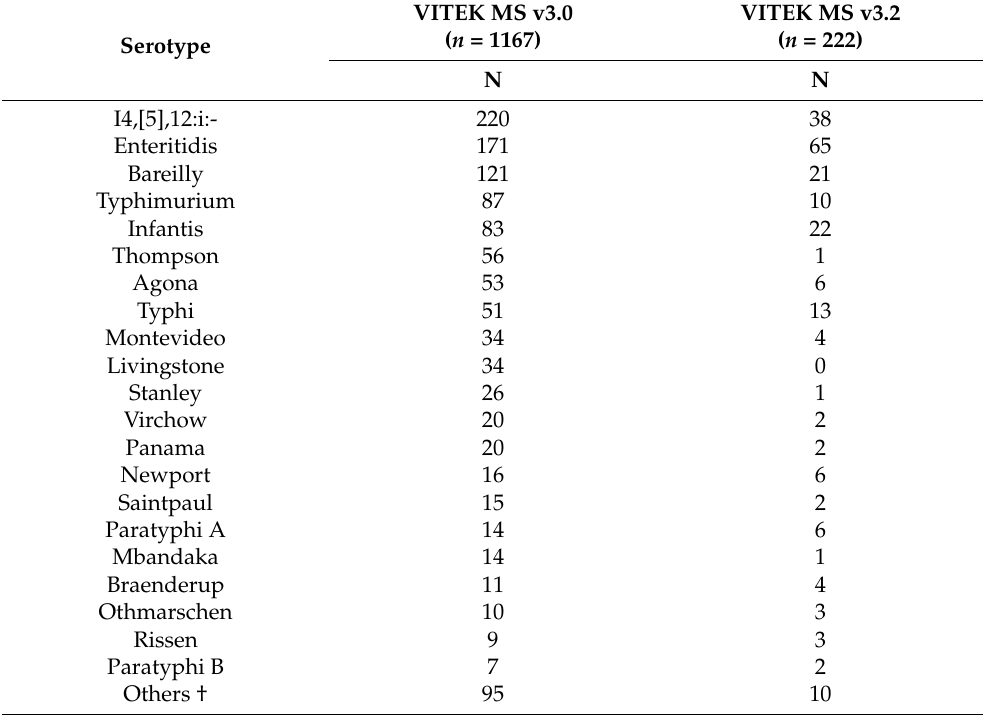
Table 2. Serotype distribution of Salmonella in this study.